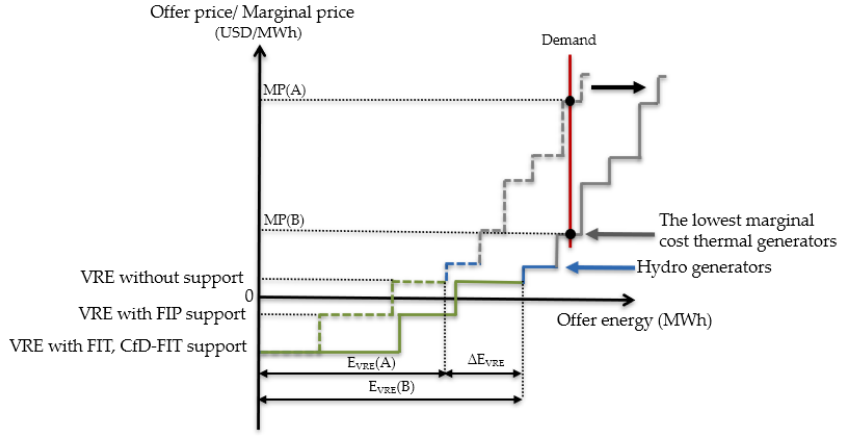
Figure 2. The concept of the merit-order model.